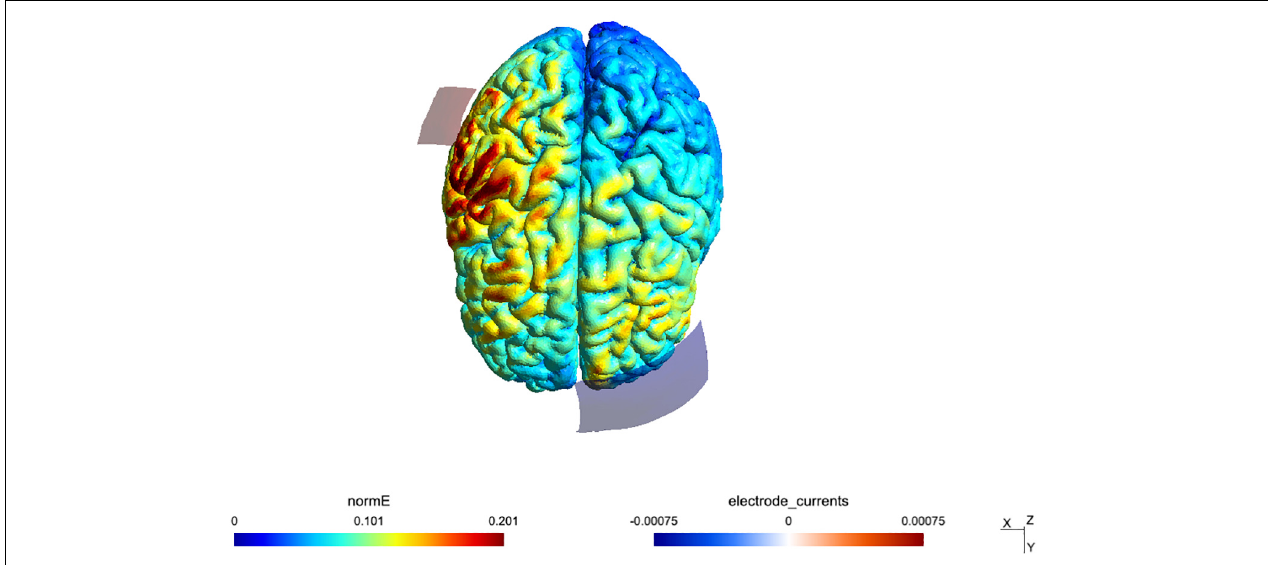
FIGURE 2 | Simulation of the TDCS electric field for the montage, done using SimNIBS 2.1 and the included “Ernie” example dataset.